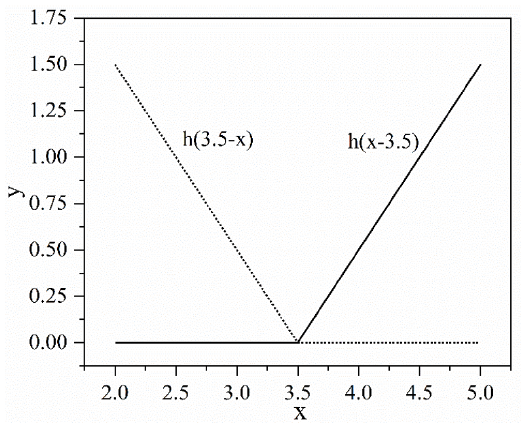
Fig. 4. A schematic exhibition of a spline BF. Dashed